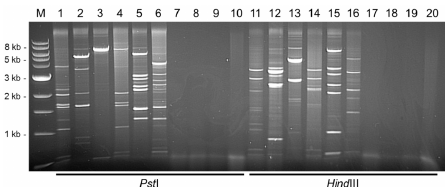
Figure 1. Restriction enzyme analysis of RCA products from DNAs of 10 Dioscorea species digested with Pst I (lane 1–10) or Hin dIII (lane 11–20) restriction enzymes analysed on 0.6% ( w / v ) agarose gel. Differing restriction digestion patterns suggest the presence of different episomal badnavirus sequences. M = 1 kb DNA ladder (NEB), lane 1 and 11 = TDr 89/02475, lane 2 and 12 = TDa 00/00005, lane 3 and 13 = TDa 85/00250, lane 4 and 14 = TDr 95/18544, lane 5 and 15 = TDa 95/00310, lane 6 and 16 = TDr 1892, lane 7 and 17 = TDa 01/00039, lane 8 and 18 = TDr 98/01166, lane 9 and 19 = TDa 89/02677 and lane 10 and 20 = TDa 96/00629.